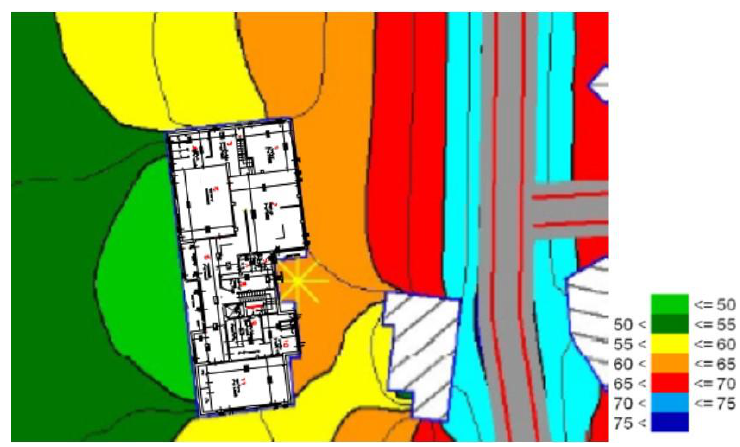
Figure 5. Typical distribution of traffic noise on the facades of a school located near a busy road.